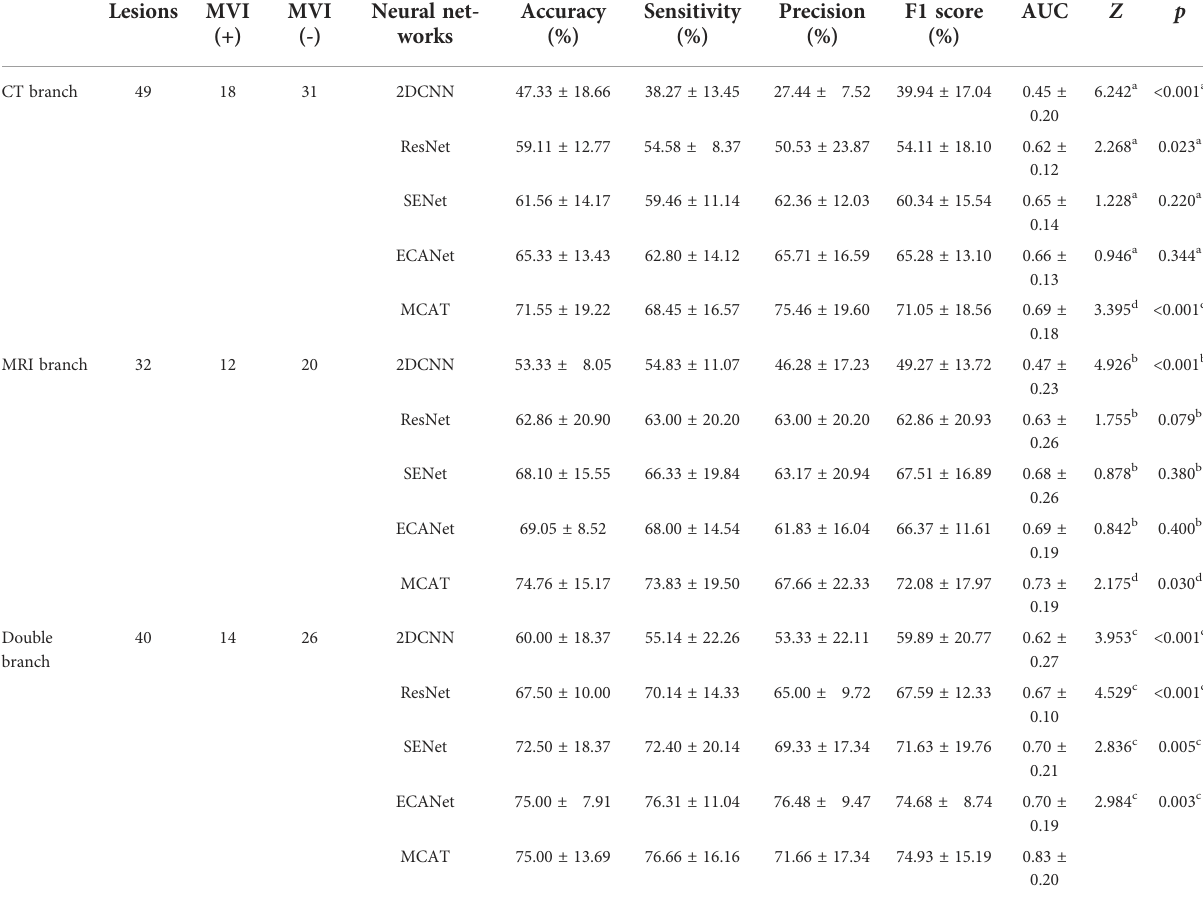
TABLE 2 Diagnostic evaluation performance of different neural networks for HCC MVI (validation data).